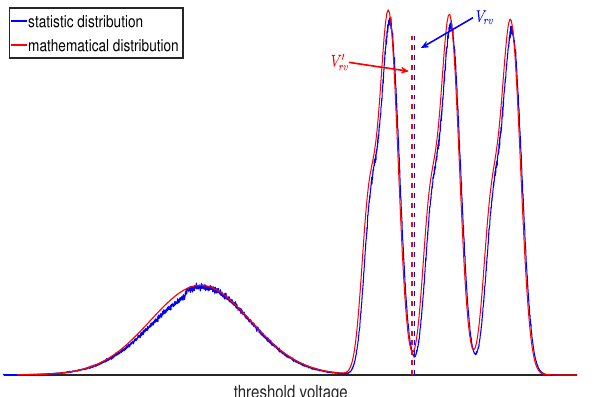
Figure 3. Illustration of the statistic distribution and mathematical distribution at s = 1 and PE = 1 K .